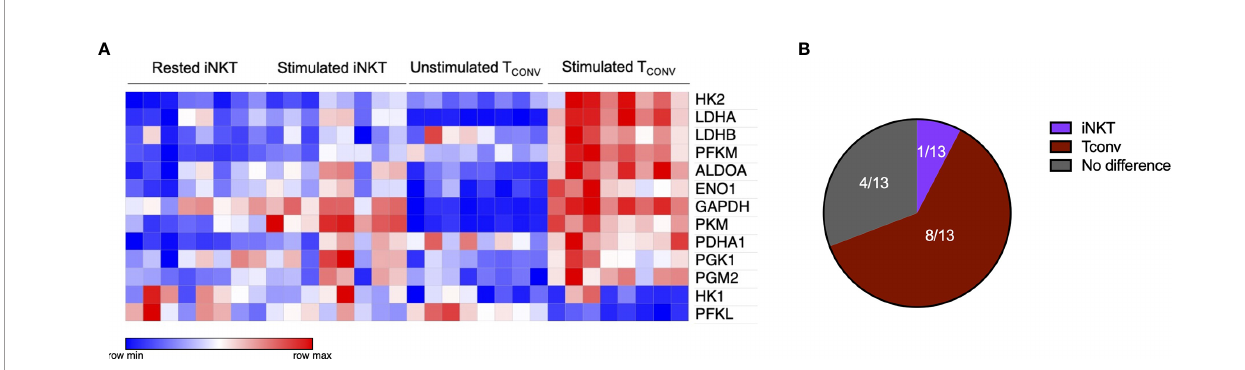
FIGURE 2 | Human iNKT cells are less glycolytic than T CONV . (A) Heatmap of 8 independent biological replicates of healthy human donor rested and stimulated iNKT cells and matched T CONV (processed per schematic in Supplementary Figure 1 ) transcriptional pro fi les for genes in the glycolysis pathway included in the NanoString nCounter Human Metabolic Pathways probe set. Genes with counts under 100 were eliminated from analysis. Coloring indicates relative expression of each gene, from low (blue) to high (red). Heatmap generated on Morpheus. (B) Pie chart graphically displaying proportion of glycolysis genes signi fi cantly higher in each stimulated cell subset as determined by student ’ s t tests (where signi fi cance was de fi ned as p < 0.05). Each set of matched donor biological replicates was independently collected, stimulated, and harvested for mRNA and all samples were run and analyzed on NanoString